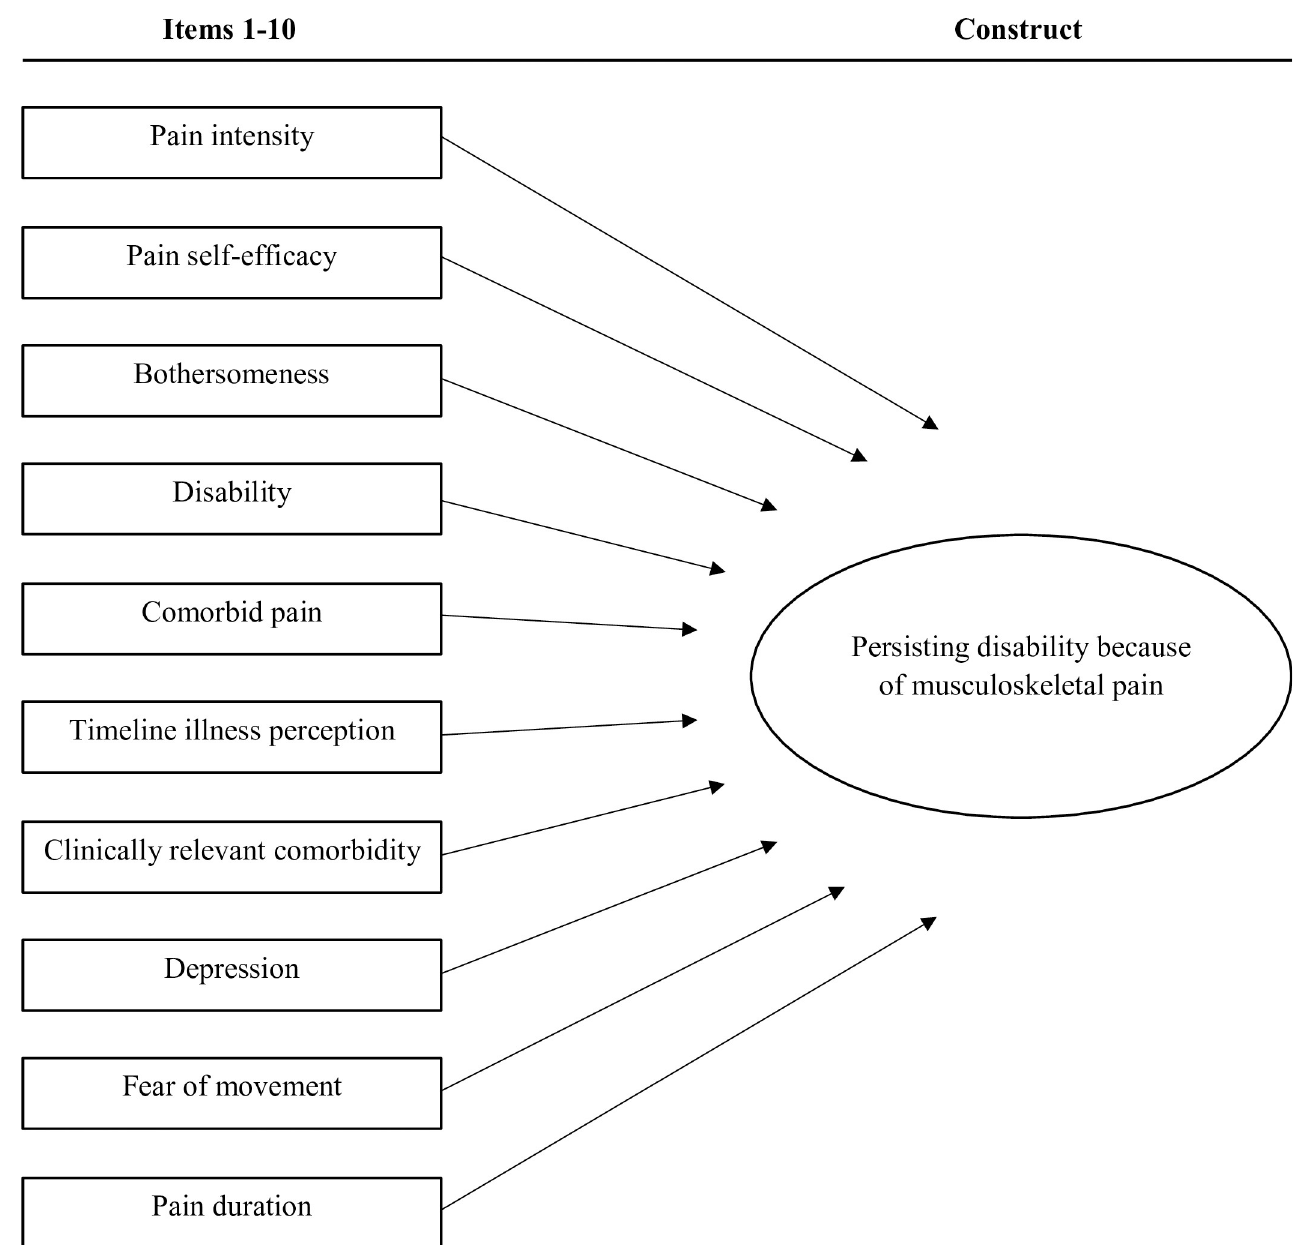
Fig 1. Graphical representation of the STarT MSK